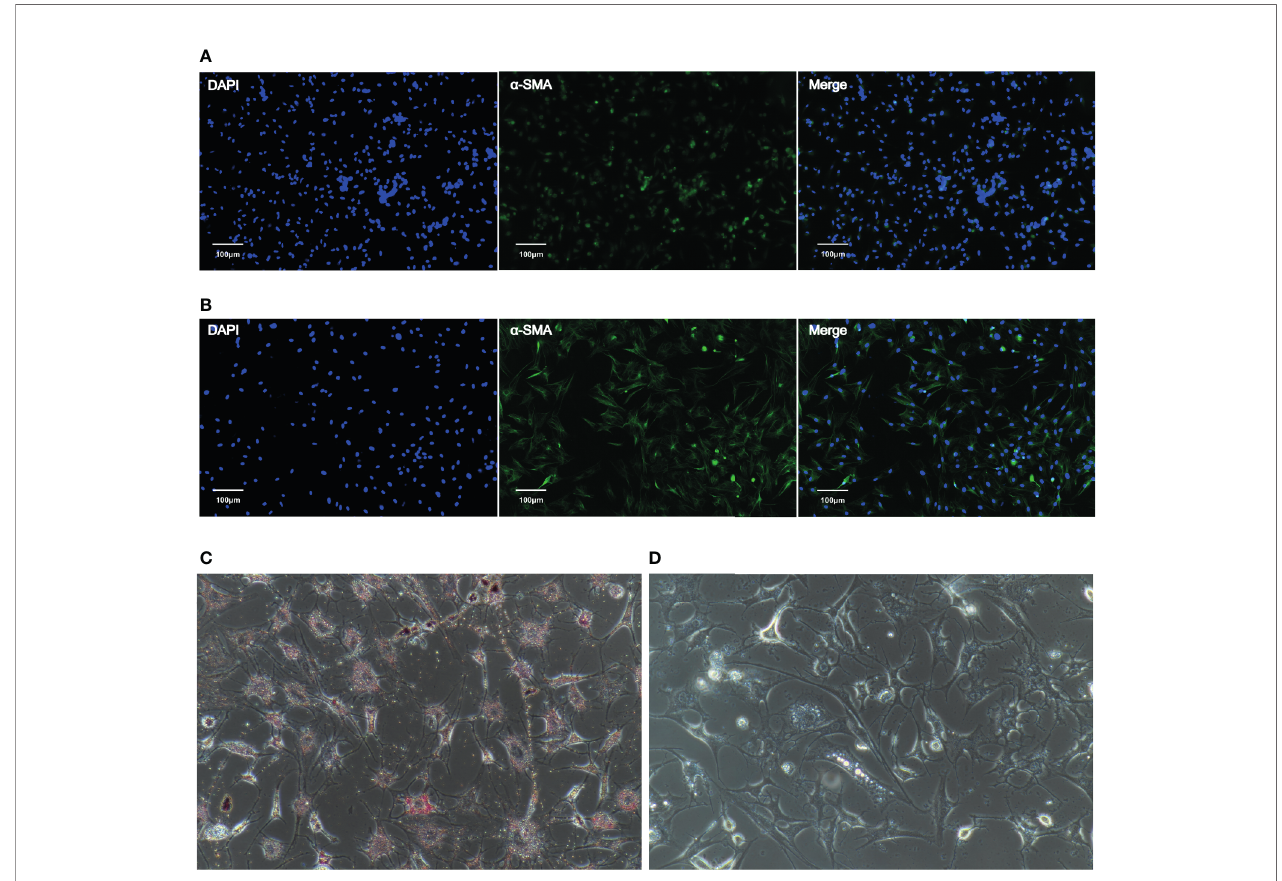
FIGURE 1 | The expression of a -SMA in NaPSCs and CaPSCs was detected by immuno fl uorescence, and CaPSCs showed a highly activated state. (A) NaPSC immuno fl uorescence — DAPI, a -SMA, MERGE; (B) CaPSC immuno fl uorescence — DAPI, a -SMA, MERGE; (C) NaPSC Oil red O staining (D) CaPSC Oil red O staining.